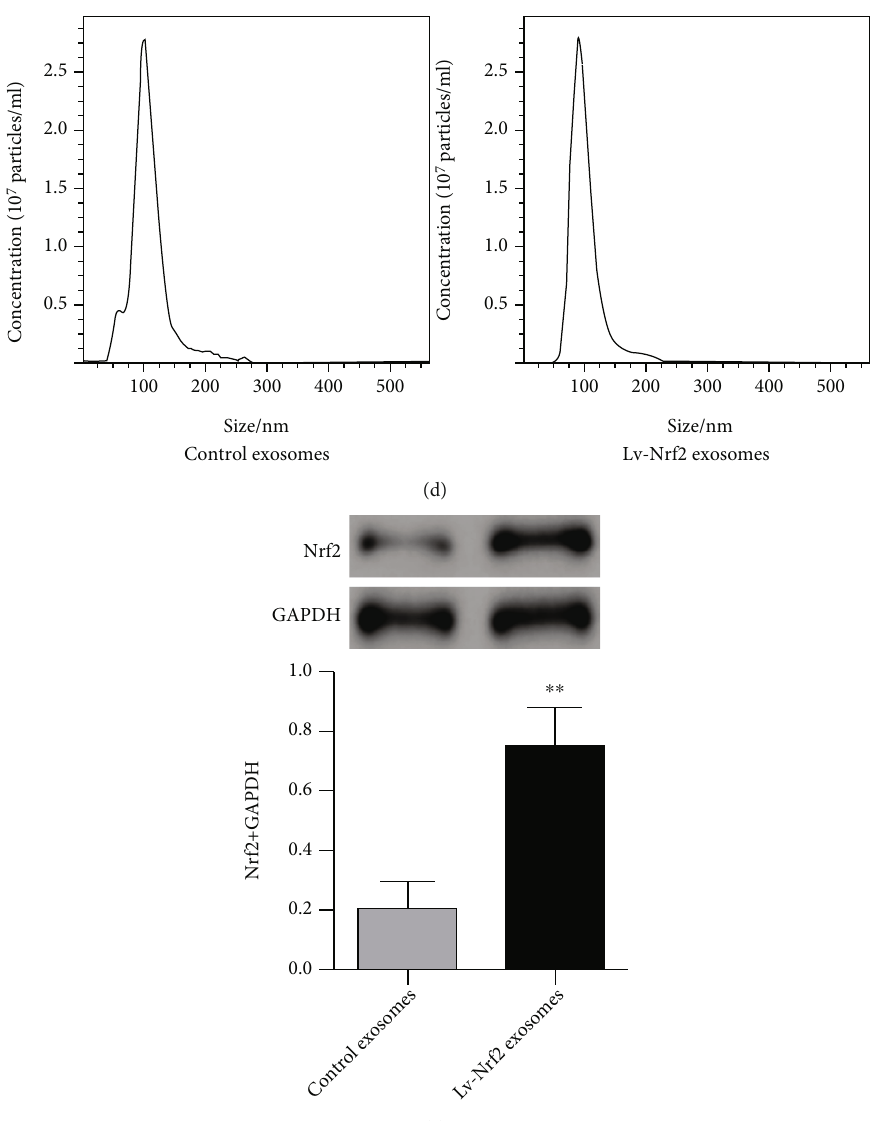
Figure 2: Characterization of exosomes derived from BMSCs. (a) BMSCs were transduced by lentivirus with overexpressed Nrf2 (Lv-Nrf2) for 48 h. Nrf2 expression was quanti fi ed by Western blot, where GAPDH served as the loading control. ∗∗ P < 0 : 01 compared to control or Lv-vector groups. (b) Exosomes derived from the control BMSCs/Lv-Nrf2 BMSCs were analyzed by transmission electron microscopy. Scale = 200nm . (c) Speci fi c exosomal surface biomarker (positive markers: CD63, CD81, CD9, Alix, and TSG101; negative marker: calnexin) expression in the BMSCs and their exosomes was detected by Western blotting. (d) Diameter/concentration of exosomes was determined through nanoparticle tracking analysis. (e) Exosomal Nrf2 expression was determined through Western blot. ∗∗ P < 0 : 01 compared to the control exosome